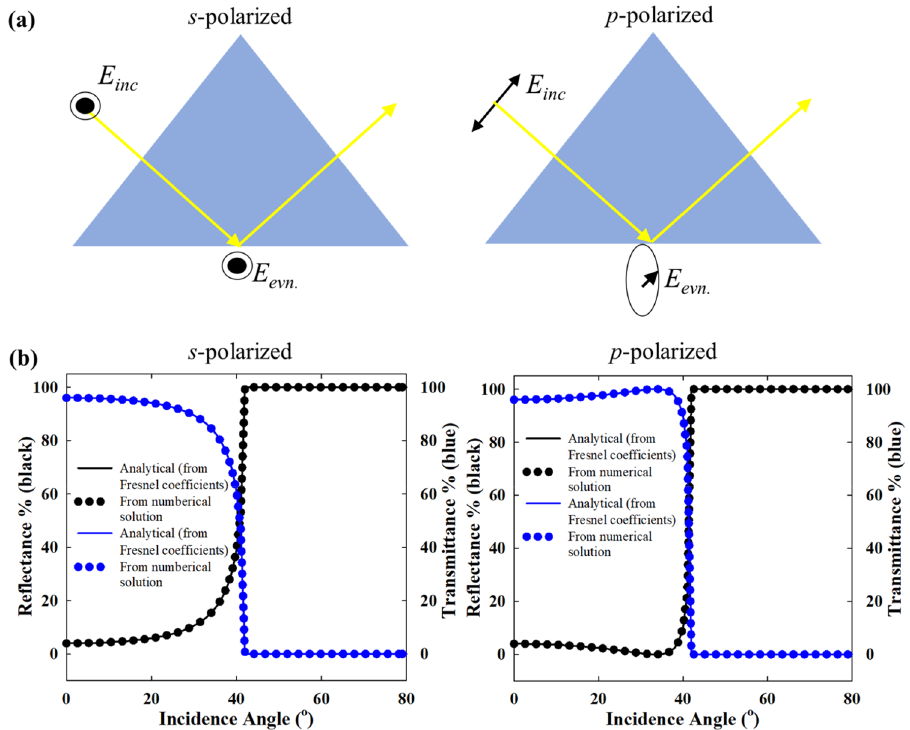
Figure 11. ( a ) Schematic representation of the evanescent field polarization for s - and p -polarized incidence in the Kretschmann configuration. ( b ) Validation of the angle resolved electromagnetic models of the Kretschmann configuration (without nanoparticles) by comparison with optical spectra obtained from the Fresnel coefficients for p- polarized i.e. TM polarized and s -polarized i.e. TE polarized